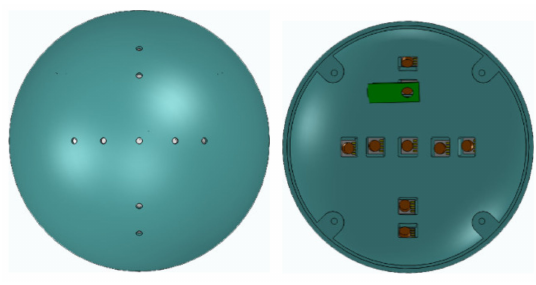
Figure 9. Installation position diagram of the pressure